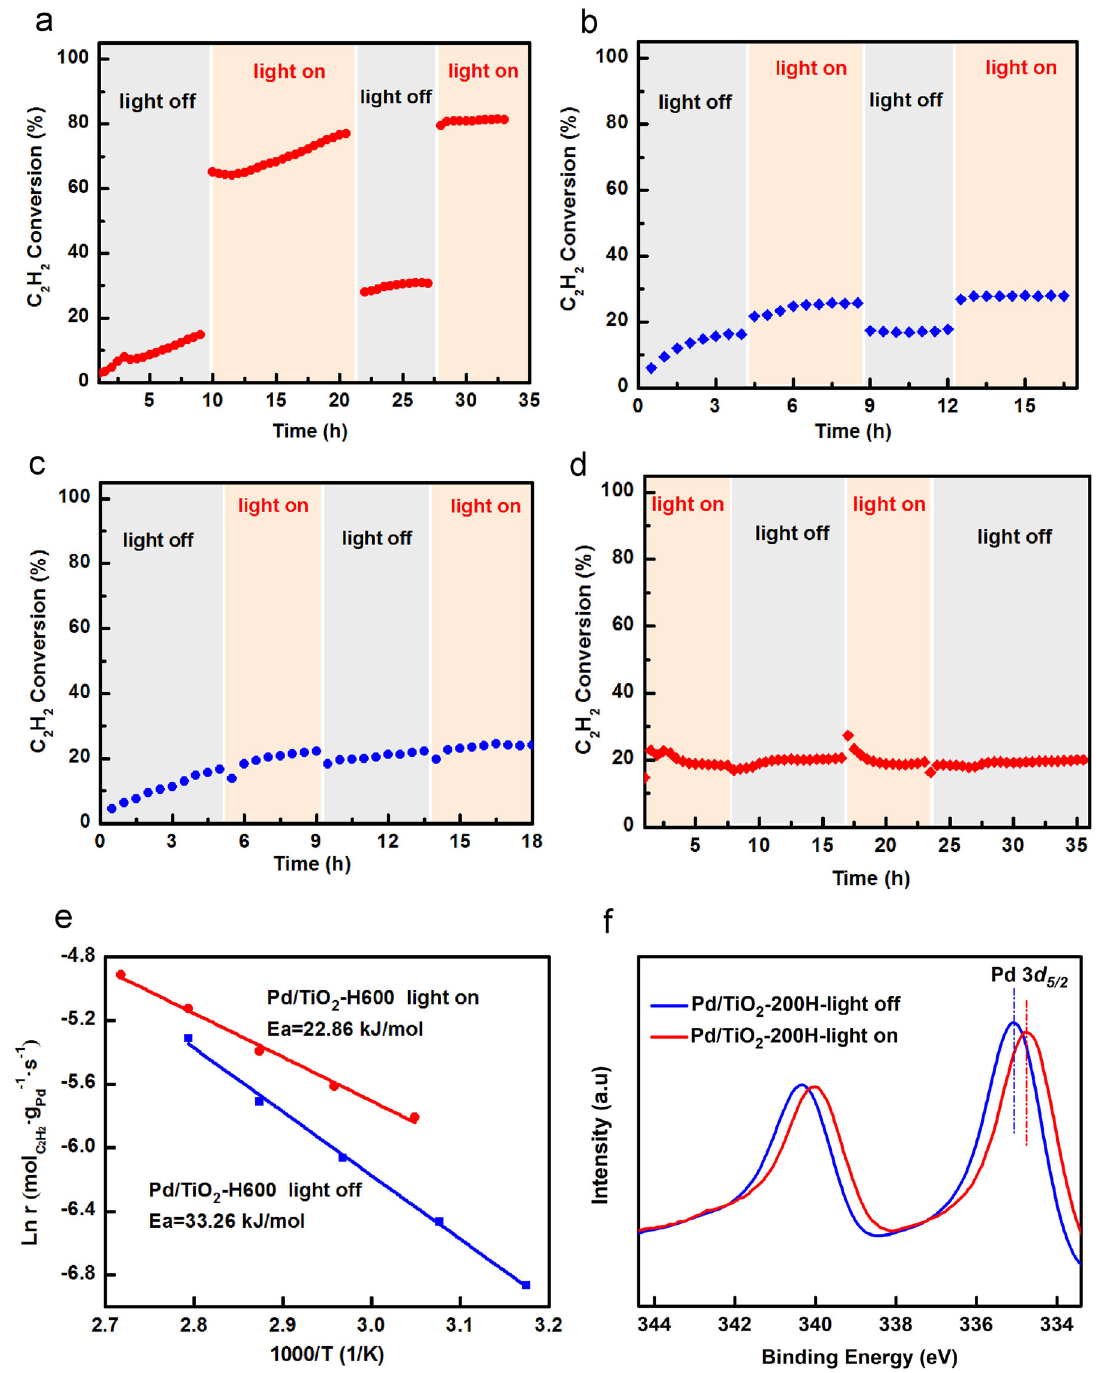
Fig. 4 Catalytic performance of photo-thermo catalysis over Pd/TiO 2 -600H, Pd/Al 2 O 3 and XPS characterization. a – c Acetylene conversion over the catalyst of 0.15 wt% Pd/TiO 2 -600H at 70 °C in the dark and 60 °C upon a full-spectrum light irradiation, power density: 167 mWcm − 2 , b visible light ( λ > 420 nm), power density: 141 mW cm − 2 and c λ > 480 nm, power density: 127 mW cm − 2 . Reaction conditions: 1 vol% C 2 H 2 , 10 vol% H 2 , 20 vol% C 2 H 4 balanced with He; WHSV = 180,000 mLh − 1 g cat − 1 . d Acetylene conversion over the catalyst of 0.036 wt% Pd/Al 2 O 3 at 70 °C in the dark and 60 °C upon full-spectrum light irradiation with the similar reaction conditions. e Arrhenius plots for acetylene hydrogenation over the Pd/TiO 2 -600H upon light irradiation or in the dark under the gas mixture of 1 vol% C 2 H 2 , 20 vol%H 2 , 20 vol% C 2 H 4 balanced with He. f Pd 3 d XPS spectra of Pd/TiO 2 -200H after light irradiation by Xe lamp as well as the catalyst in irradiation was conducted at WHSV = 360,000 mL h − 1 g cat − 1 , Supplementary Fig. 13. The acetylene activity is boosted with the increased power density from 133 to 270 mW cm − 2 accompanied by an opposite trend in ethylene selectivity. Moreover, kinetic measurement suggests that the apparent activation energy in